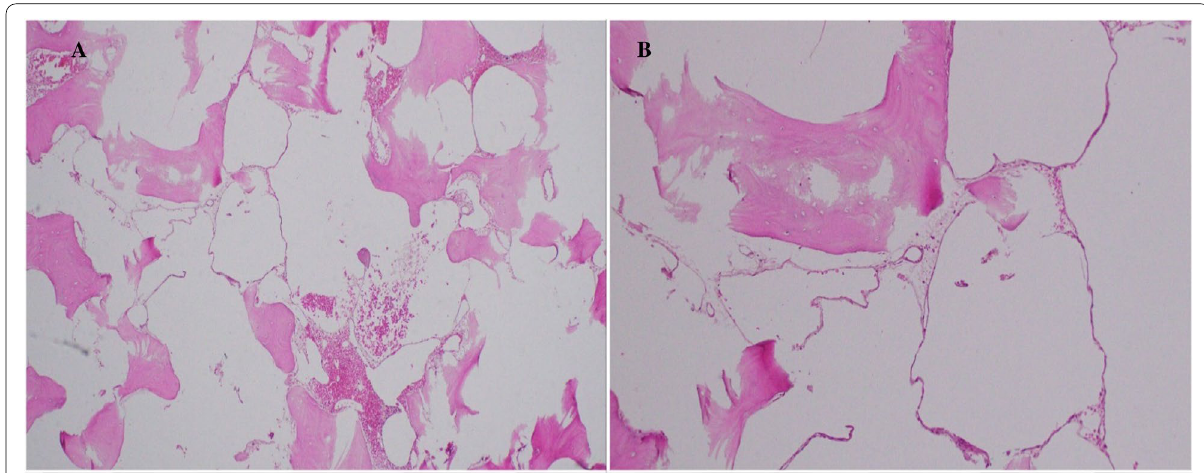
Fig. 7 A Microscopy of hematoxylin and eosin, skull mass shows replacement of bone trabeculae and marrow space by multiple distended blood vessels. B Microscopy of high magnification shows multiple blood vessels with red blood cells and flat endothelial lining